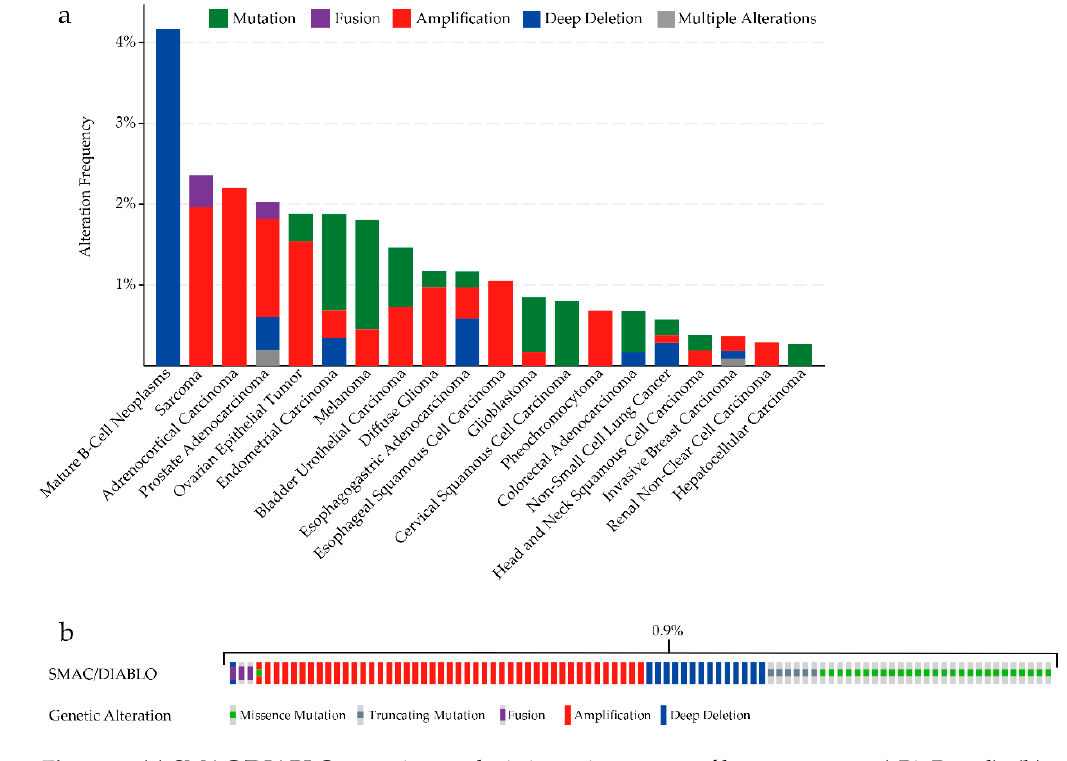
Figure 2. ( a ) SMAC/DIABLO mutation analysis in various types of human cancers (cBioPortal). ( b ) Oncoprint in cBioPortal representing the proportion and distribution of samples with alterations in SMAC/DIABLO. Cancers without mutations and samples without alterations are not shown in the